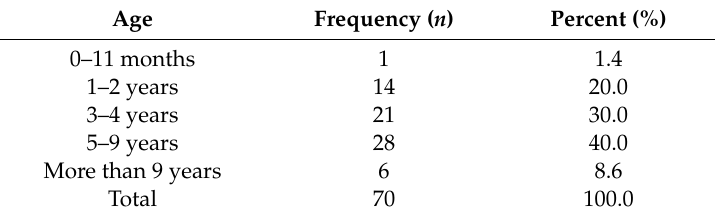
Table 4. Age of dogs aggressive towards other dogs.